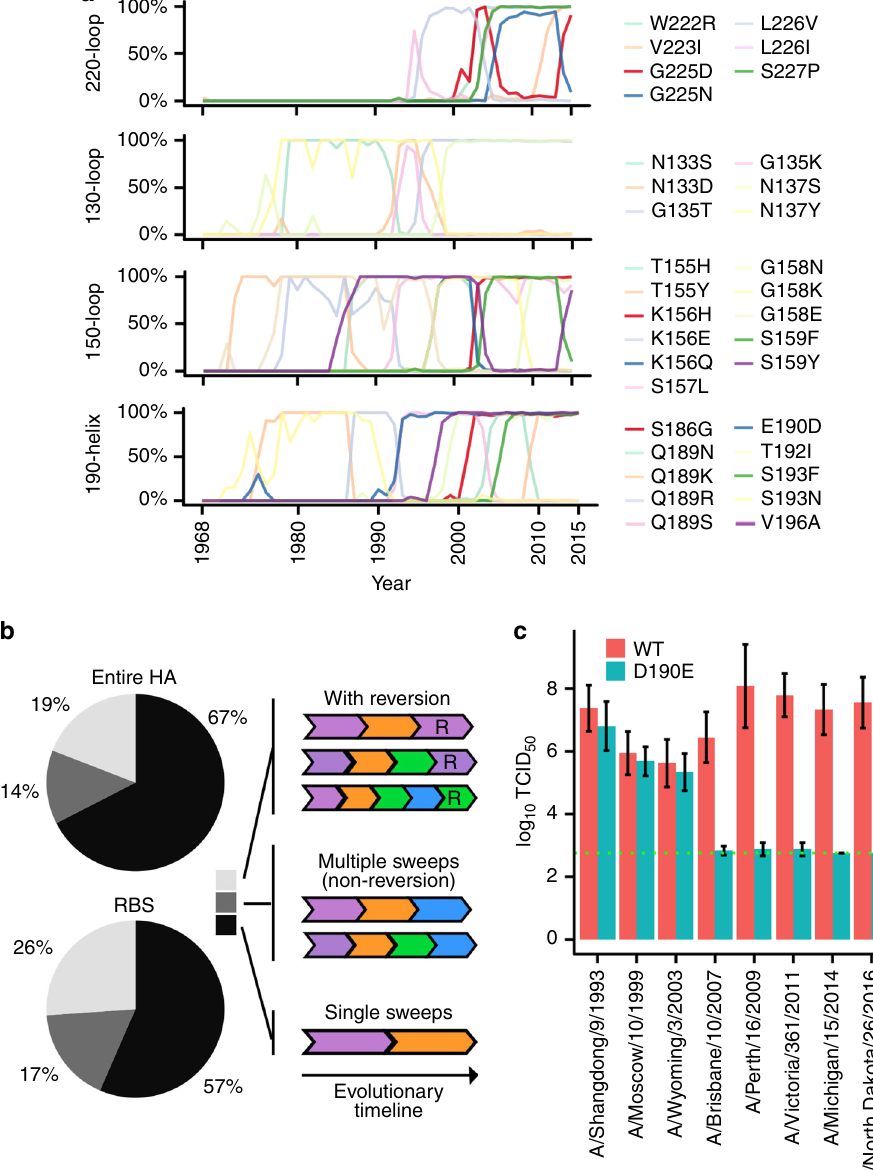
Fig. 1 Evolution of HA RBS and the mutability of residue 190. a The frequencies of several representative substitutions in HA RBS in naturally circulating human H3N2 strains are shown. b Residues that are involved in selective sweeps during the natural evolution of human H3N2 viruses were analyzed for the entire HA and for the RBS, and were further classi fi ed into “ with reversion ” , “ multiple sweep ” , and “ single sweep ” (see Methods). The cartoon arrows on the right demonstrate several scenarios for the classi fi cation scheme. The evolutionary timeline of a given residue is shown from the left to right, where different colors represent different dominant amino-acid variants at the given residue. “ R ” indicates the occurrence of reversion. c Effect of D190E on viral replication fi tness for different chimeric H3N2 strains was examined by virus rescue experiment. Virus titer was measured by TCID 50 . Error bars indicate the standard deviation of three independent experiments. The green dashed line represents the lower detection